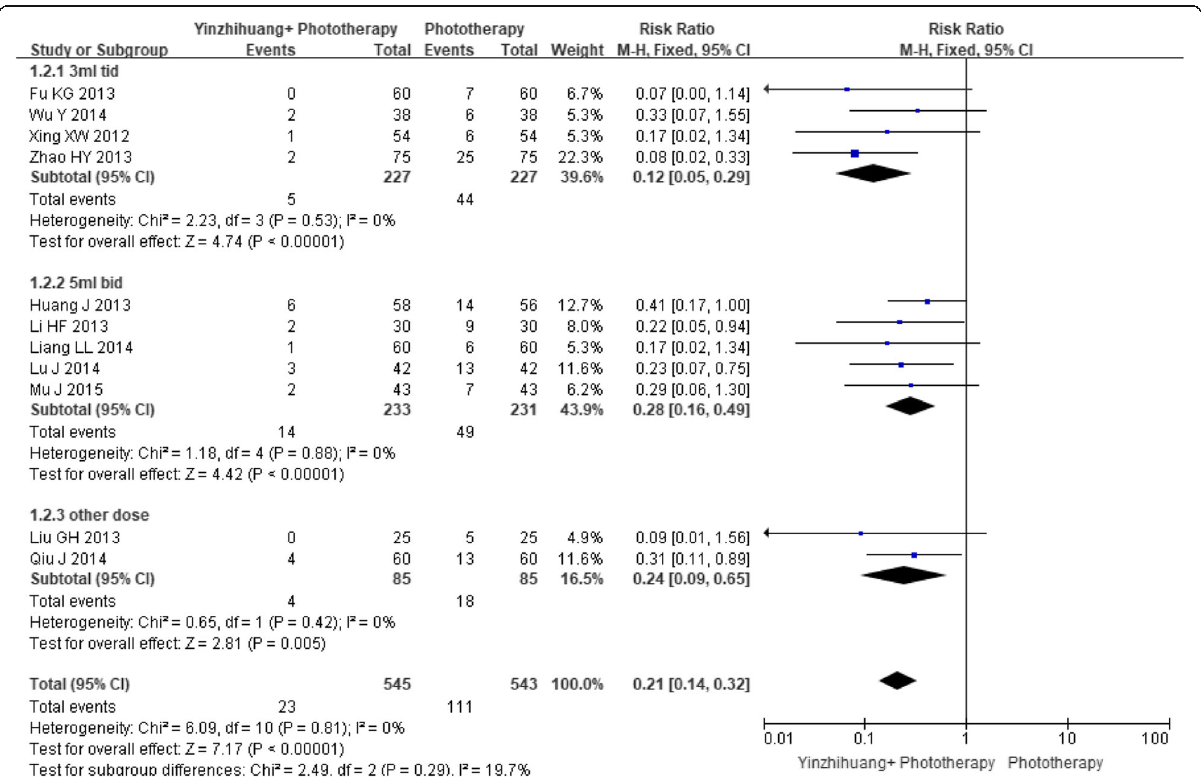
Fig. 5 Forest plot of failure of jaundice resolution and subgroup analysis based on dosage of Yinzhihuang oral